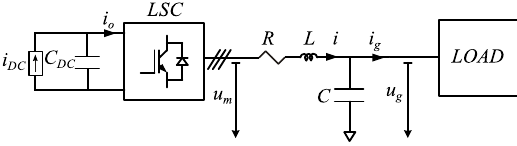
Figure 3. Scheme of the voltage-sourced converter (VSC)